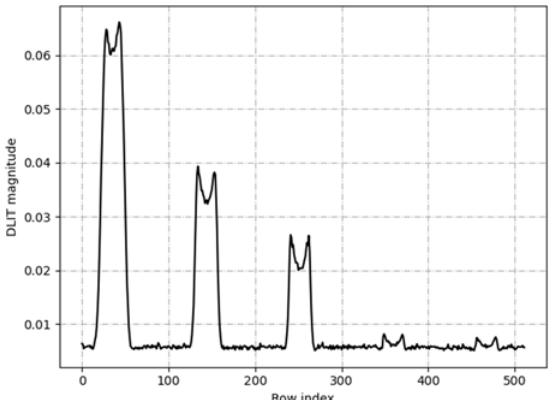
Figure 12. Demonstration of intensity estimate per row based on data shown in Figure